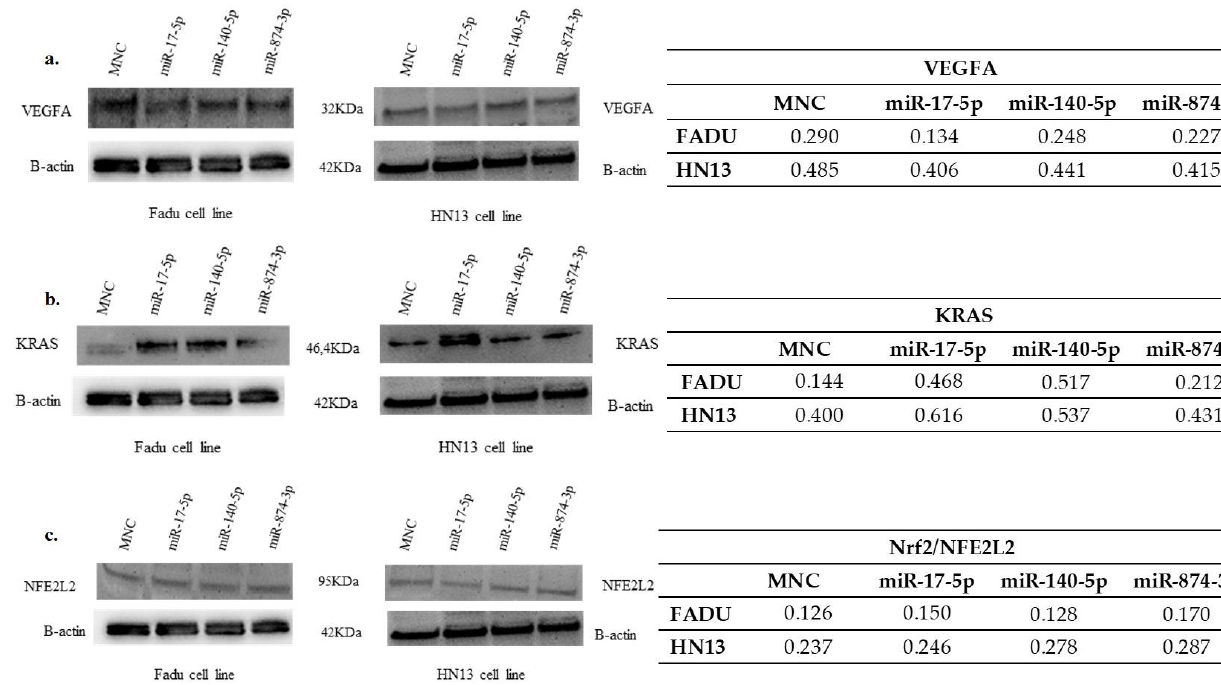
Figure 5. ( a ) VEGFA protein expression in HNC cancer cell lines expressing miRNAs. ( b ) KRAS protein expression in HNC cancer cell lines expressing miRNAs. ( c ) NFE2L2 protein expression in HNC cancer cell lines expressing miRNAs. Abbreviation: MNC, mimic negative control. For the evaluation of protein expression, the images were analyzed and quantified using ImageJ 4.0 soft- ware.